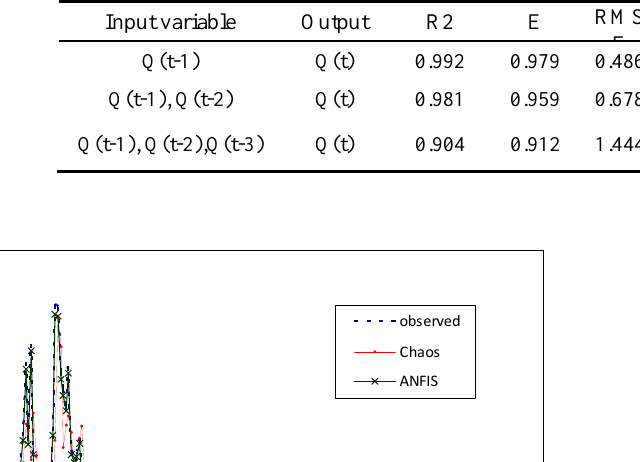
Table 3 Result of ANFIS model with different input variable